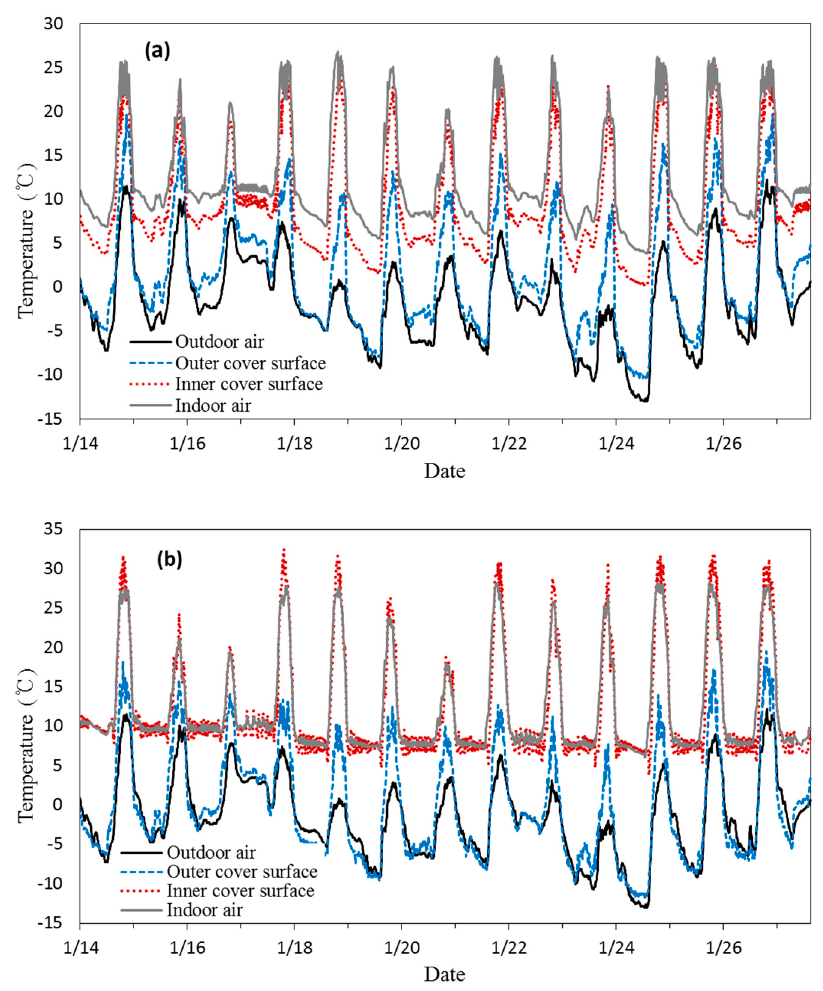
Figure 3. Variations in outdoor air, outer cover surface, inner cover surface, and indoor air temperature from 14–28 January 2016, ( a ) without thermal curtains, and ( b ) with thermal